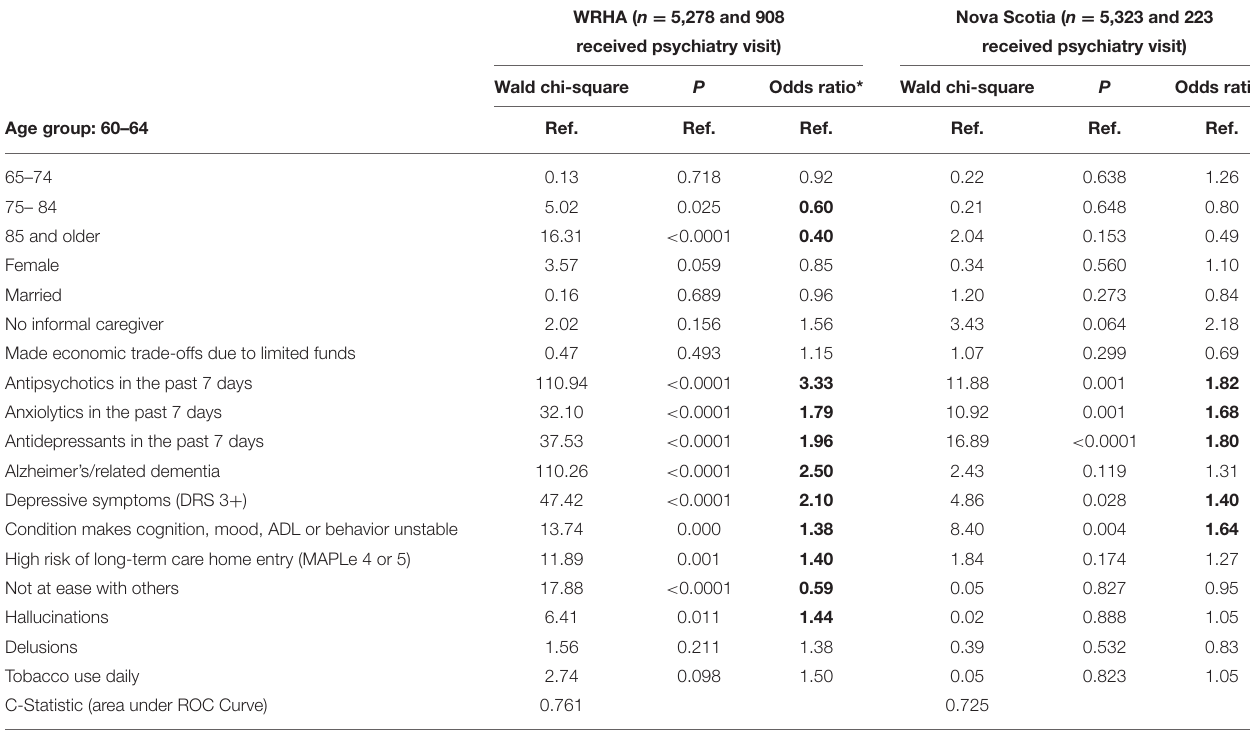
TABLE 5 | Multivariable logistic regression models of clients receiving any psychiatry visits within each provincial